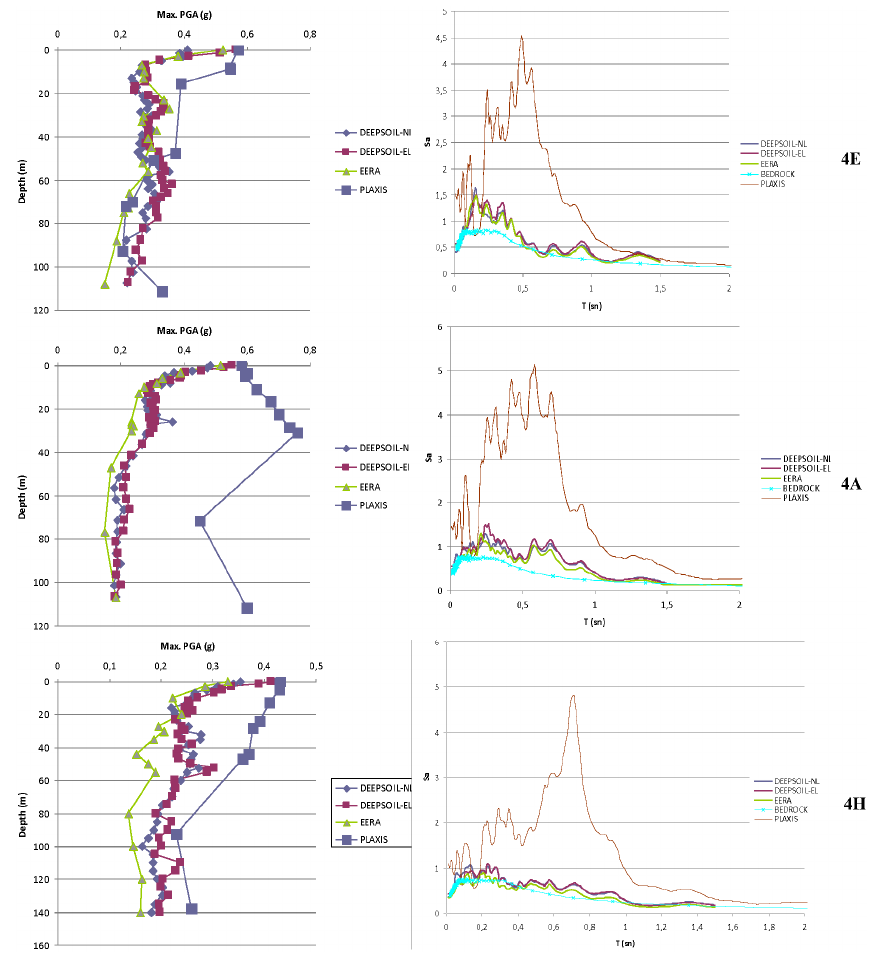
Figure 18. 4-4 0 section; maximum acceleration depth and spectral acceleration period graph for the selected